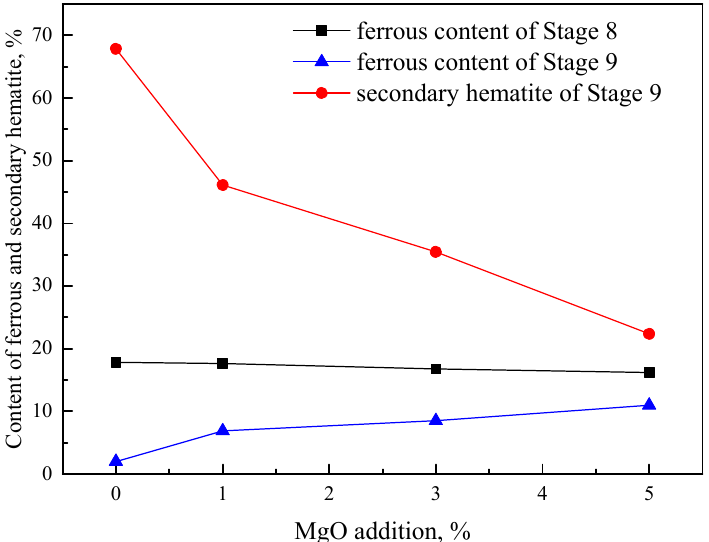
Figure 7. Effect of MgO addition on formation of secondary hematite.